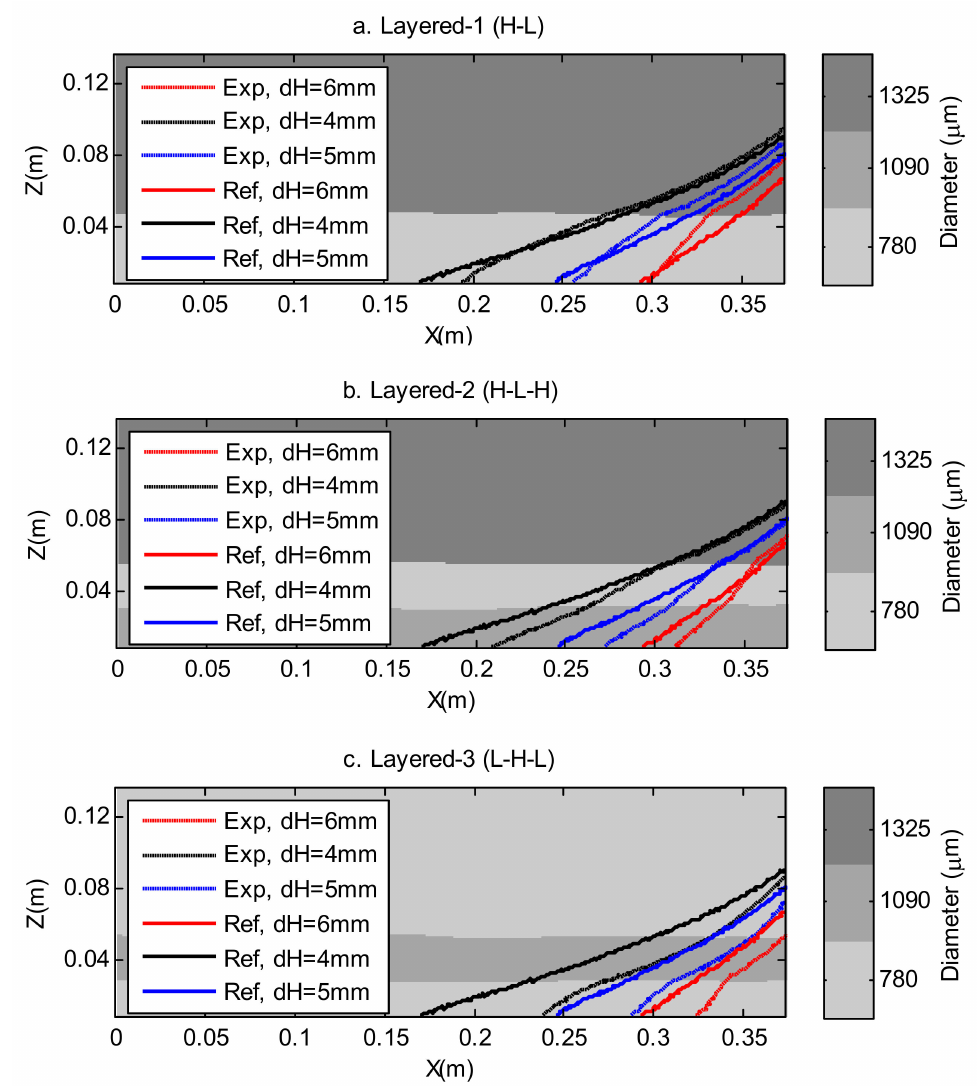
Figure 4. Experimental steady-state 50% salt concentration isolines for the layered cases compared to the homogeneous reference case, at head differences, dH = 6 mm, 4 mm, and 5 mm. (( a ) High-Low,